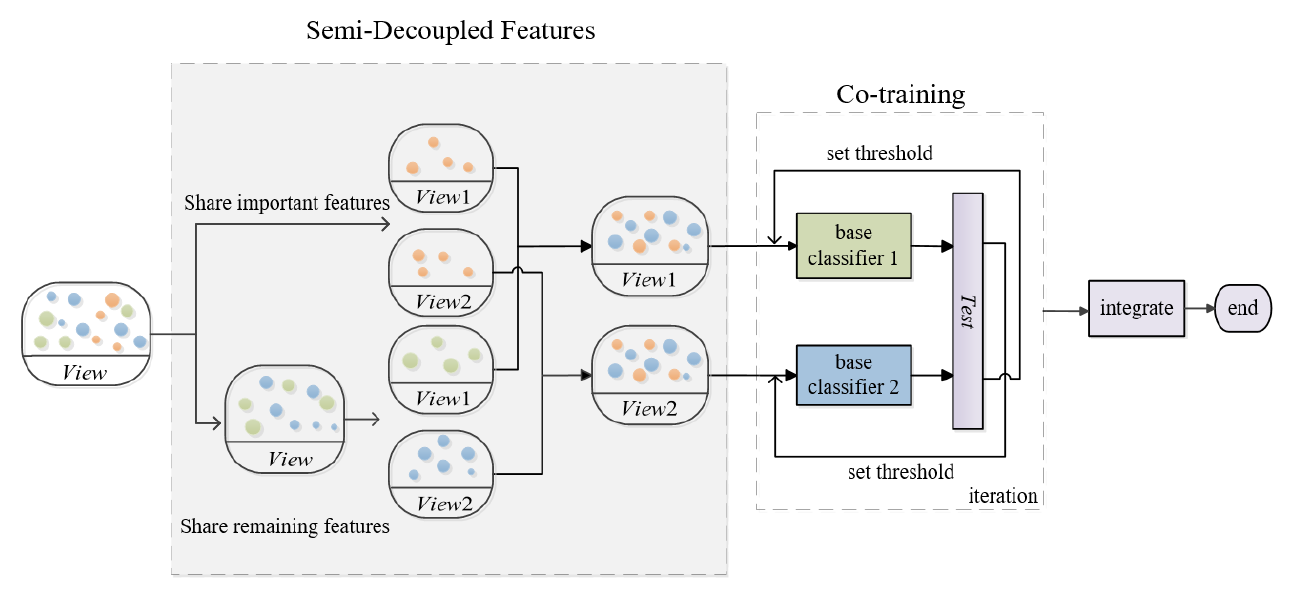
Figure 4. The process of semi-decoupled feature co-training. Orange parts: the important features; blue and green parts: the remaining features.